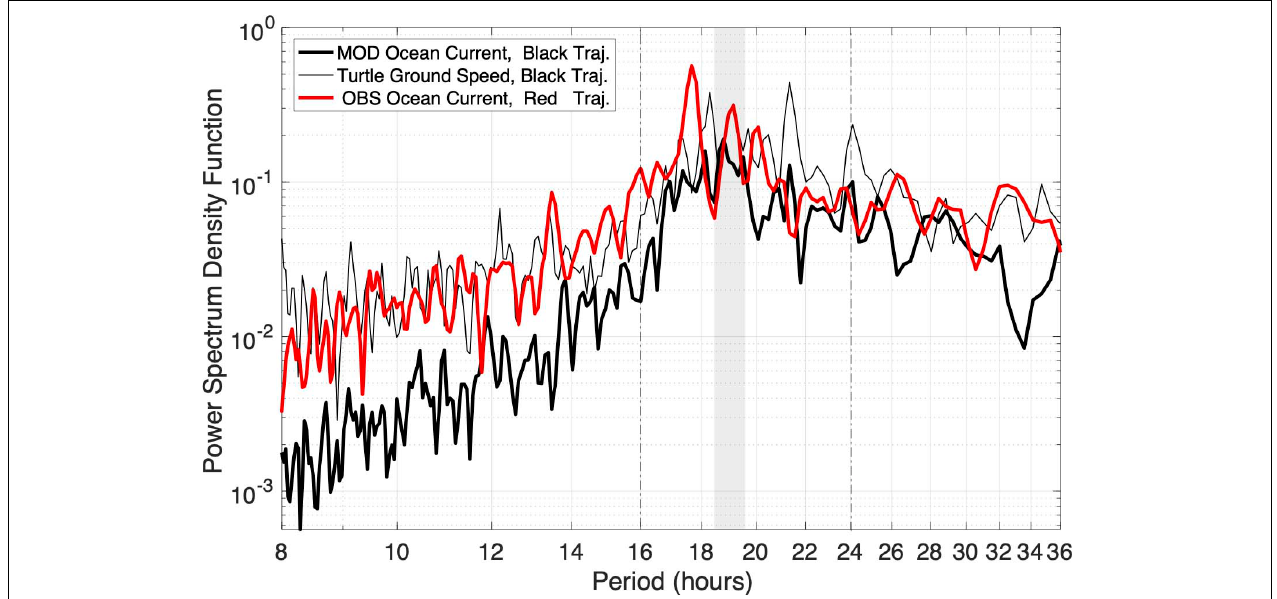
FIGURE 2 | PSDF of the loggerhead turtle (LT) ground velocity (thin black line), the MOD sea current velocity (thick black line) and the OBS sea current velocity (red line). X- and y-axes are displayed in logarithmic scale. Dashed vertical lines and the gray shadow area highlight relevant periodicity ranges.